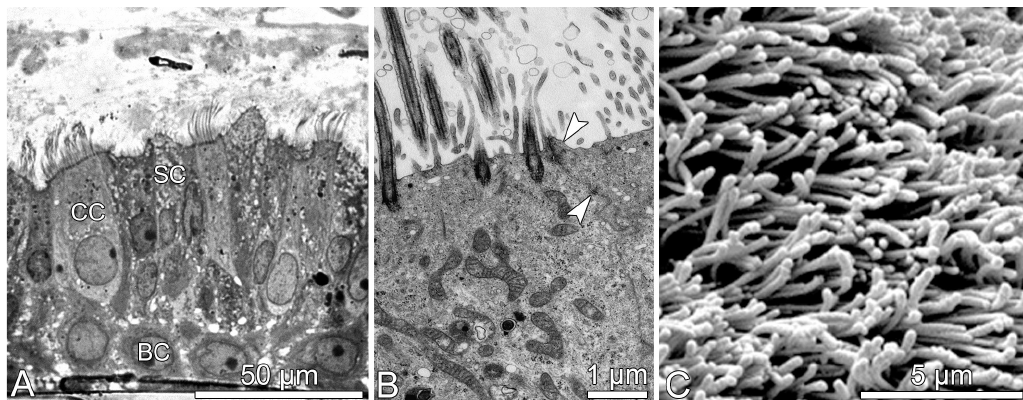
Figure 4. Morphology of in vitro differentiated human bronchial epithelia. ( A ) Light microscopic image exhibiting pseudostratified epithelium with basal (BC), ciliated (CC), and secretory (SC) cells; ( B ) transmission; and ( C ) scanning electron micrographs showing apical cell differentiations (cilia and microvilli) and junctional complexes (arrow heads in B